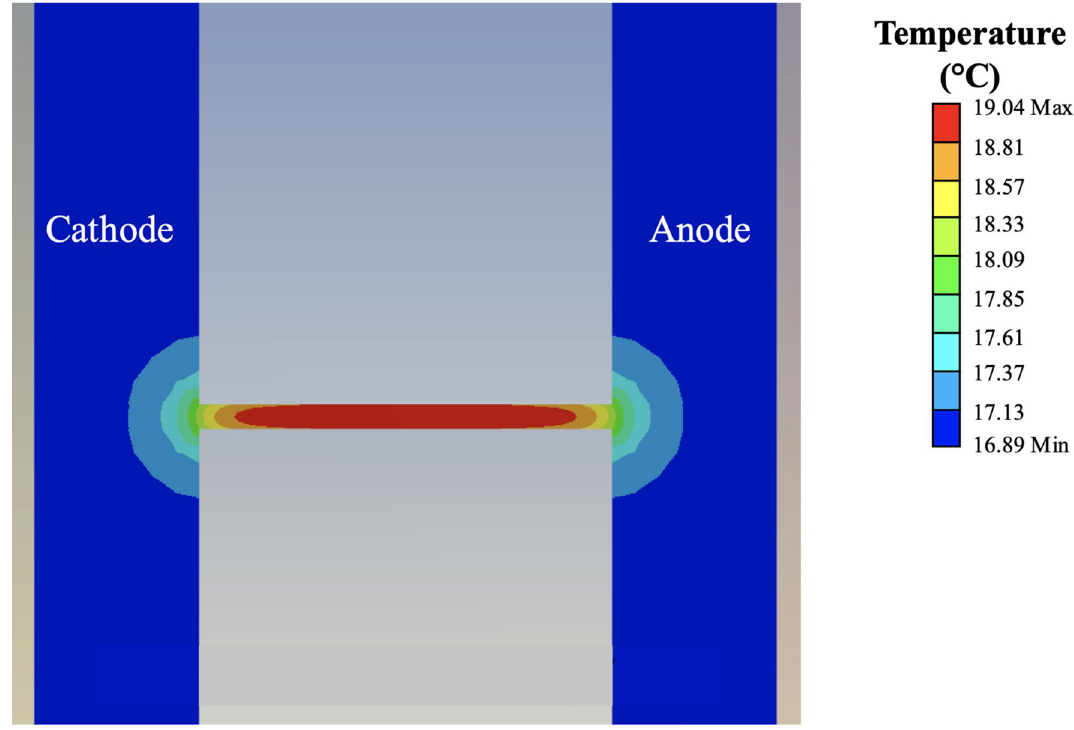
Figure 5. Temperature distribution of the sample.